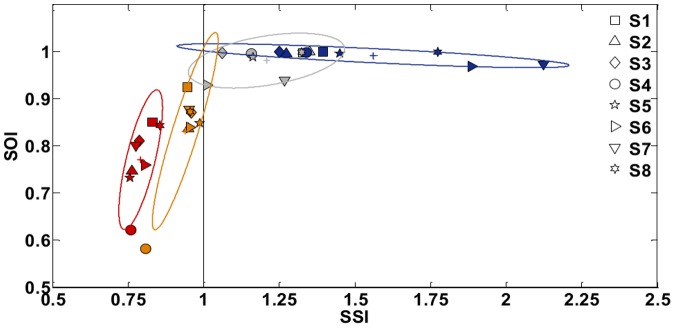
Task A: SOI (Stiffness Orientation Index) vs. SSI (Stiffness Size Index).Effect of training for becoming expert users. The displayed average values are related to the early phase of training (SSS: blue; PSS: gray) and the final phase (SSS: orange; PSS: red), for all the eight subjects (S1 –S8). The shaded area represents the ellipse of variation along the principal components over the four conditions; ‘+’ symbols are the centroids of the distributions.